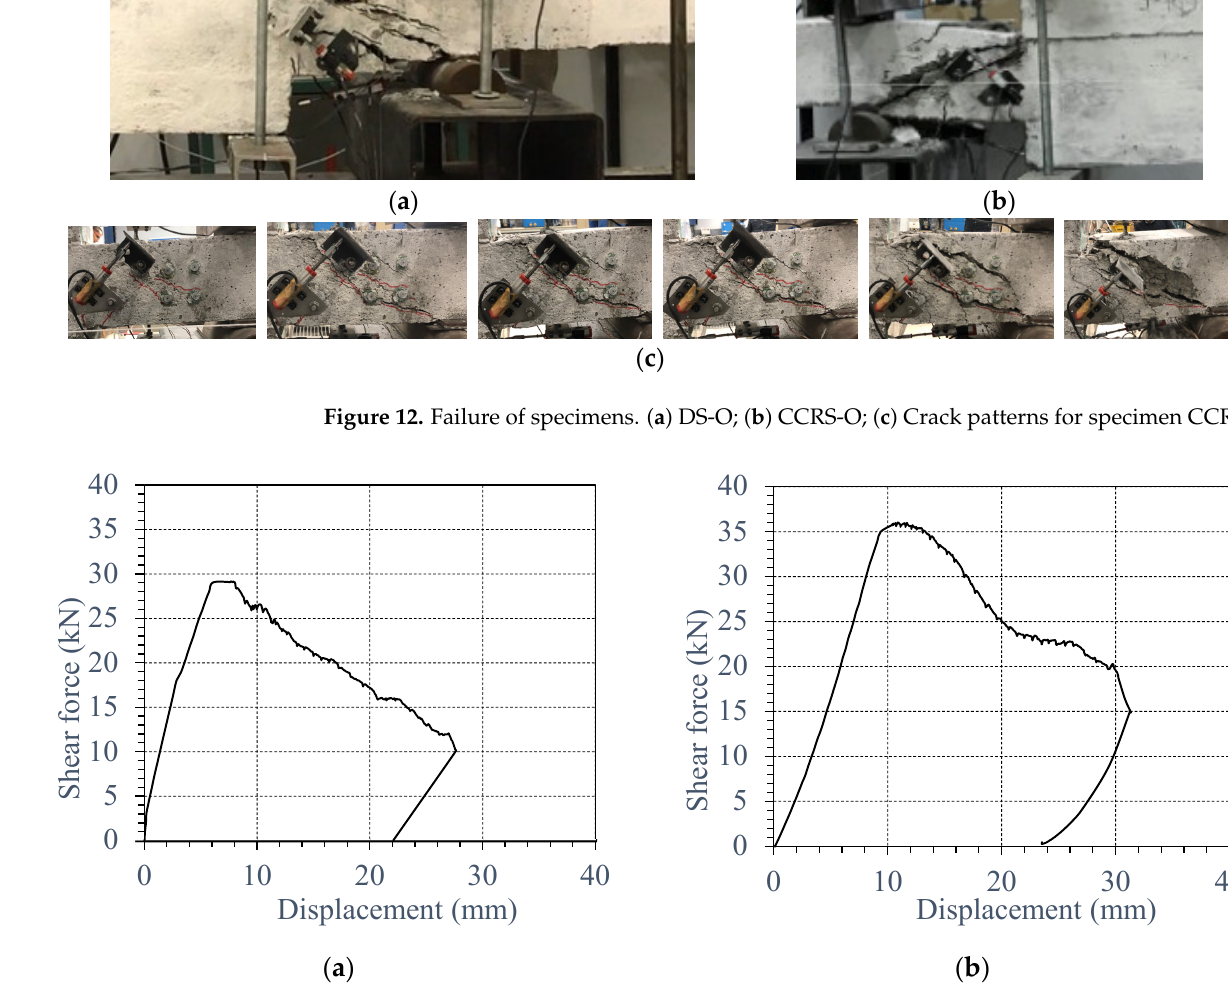
Figure 13. Force–displacement relationships of specimens. ( a ) DS-O; ( b ) CCRS-O. In retrofitted specimens, the same axial and lateral loading procedures were applied, and at 10 kN and 19 kN lateral loads, the first flexural cracks (<0.1 mm) were observed for specimens DS-R and CCRS-R, respectively (Figure 14). As seen in Figure 14, the slope of